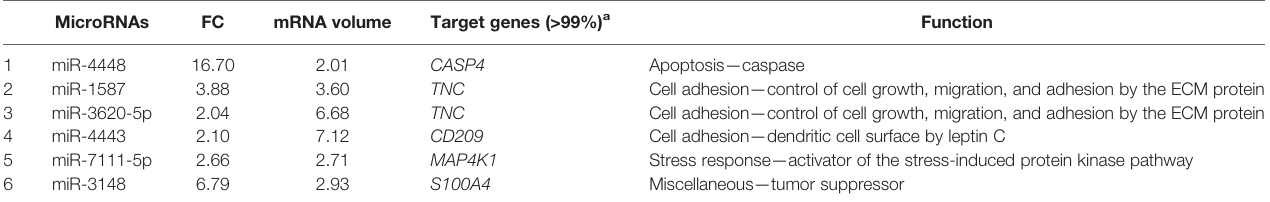
ffiffiffiffiffiffiffiffiffiffiffiffiffiffiffiffiffiffiffiffiffiffiffiffiffiffiffiffiffiffiffiffiffiffiffiffiffiffiffiffiffiffiffiffiffiffiffiffiffiffiffiffiffiffiffiffiffiffiffiffiffiffiffiffiffiffiffiffiffiffiffiffiffiffiffiffiffiffiffiffiffiffiffiffiffiffiffiffiffiffiffiffiffiffiffiffiffiffiffiffiffiffi p normalized control value (cid:1) normalized DPG value